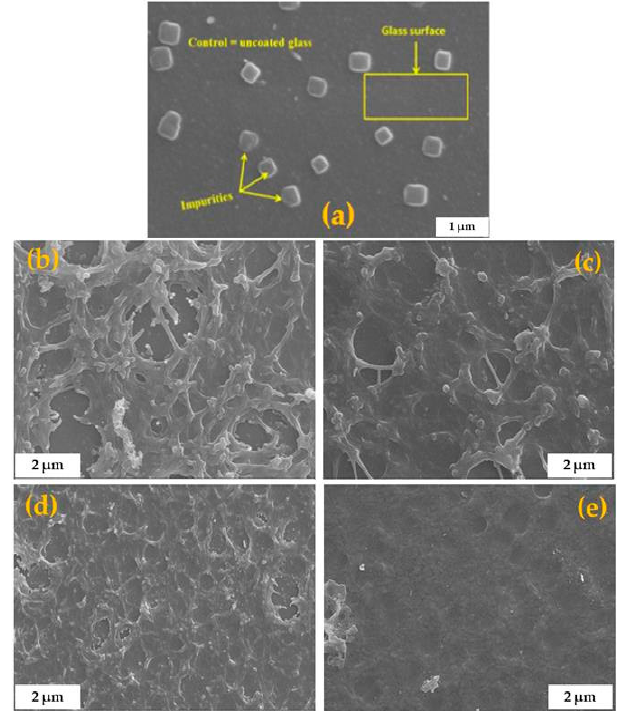
Figure 5. Scanning electron microscopy (SEM) morphology of uncoated glass ( a ) and annealed films of C-N-TiO 2 coated on support at different rotating speeds 2000 ( b ), 2300 ( c ), 2600 ( d ), to 2900 ( e ) rpm), and constant sol gel-solvent volume ratio of 3:5 for 90 s. The samples were annealed in N 2 at 350 °C (ramping rate of 10 °C/min) for 105 min.